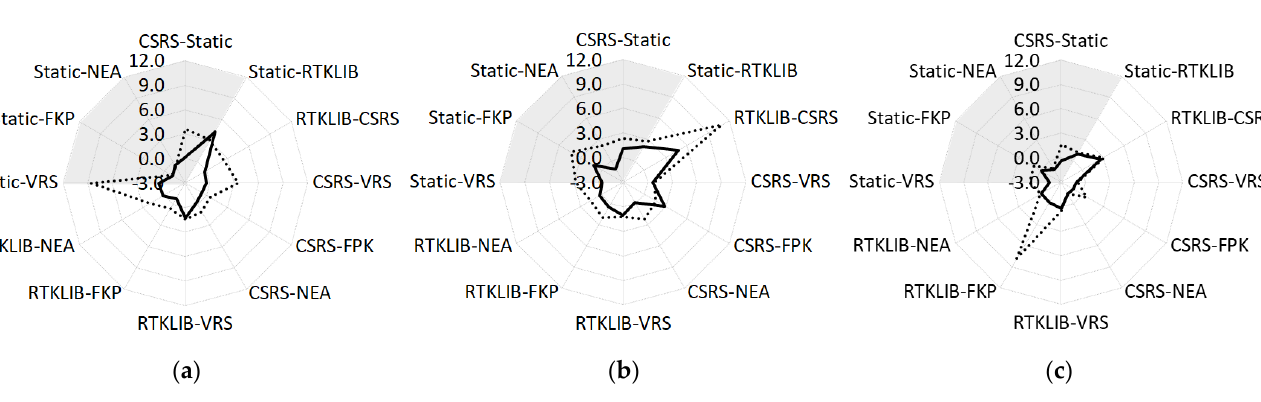
Figure 5. Skewness, S: ( a ) Δ N; ( b ) Δ E; ( c ) Δ h differences, pre and post outliers’ removal (dashed and continuous lines, respectively).